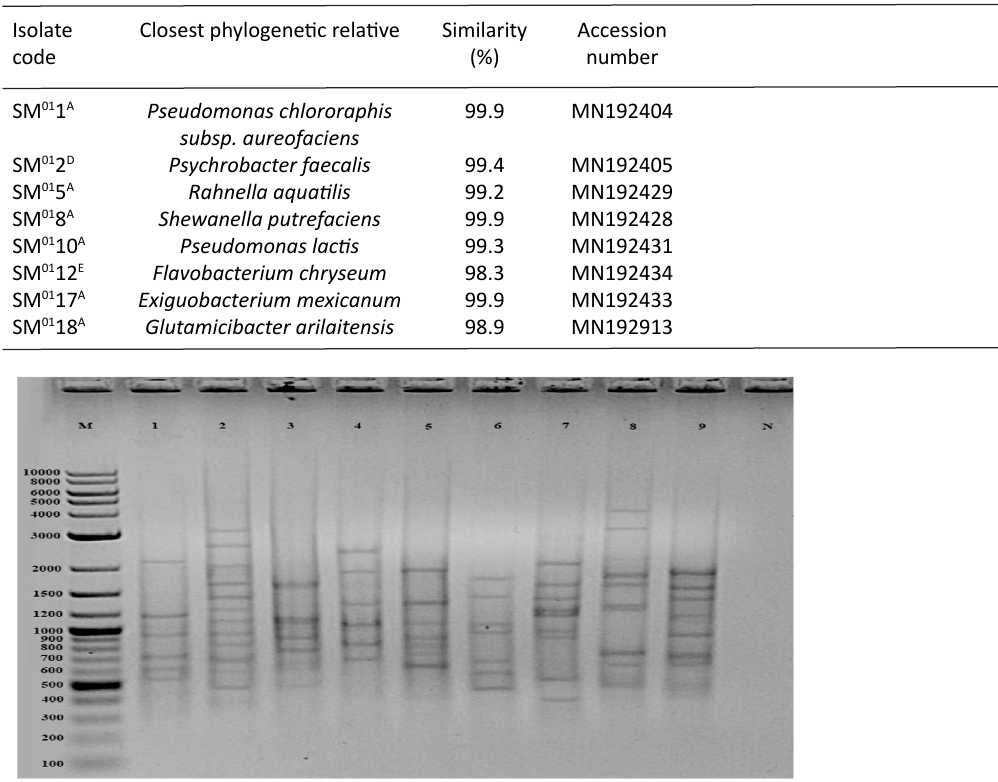
profile of cold-adaptive isolates (M: marker, 1:SM 01 1 A , 2:SM 01 2 D , 3:SM 01 5 A , 4:SM 01 8 A , 5:SM 01 8 F , 6:SM 01 10 A , Fig. 1. (GTG) 5 7:SM 01 12 E , 8:SM 01 17 A , 9:SM 01 18 A , N: negative